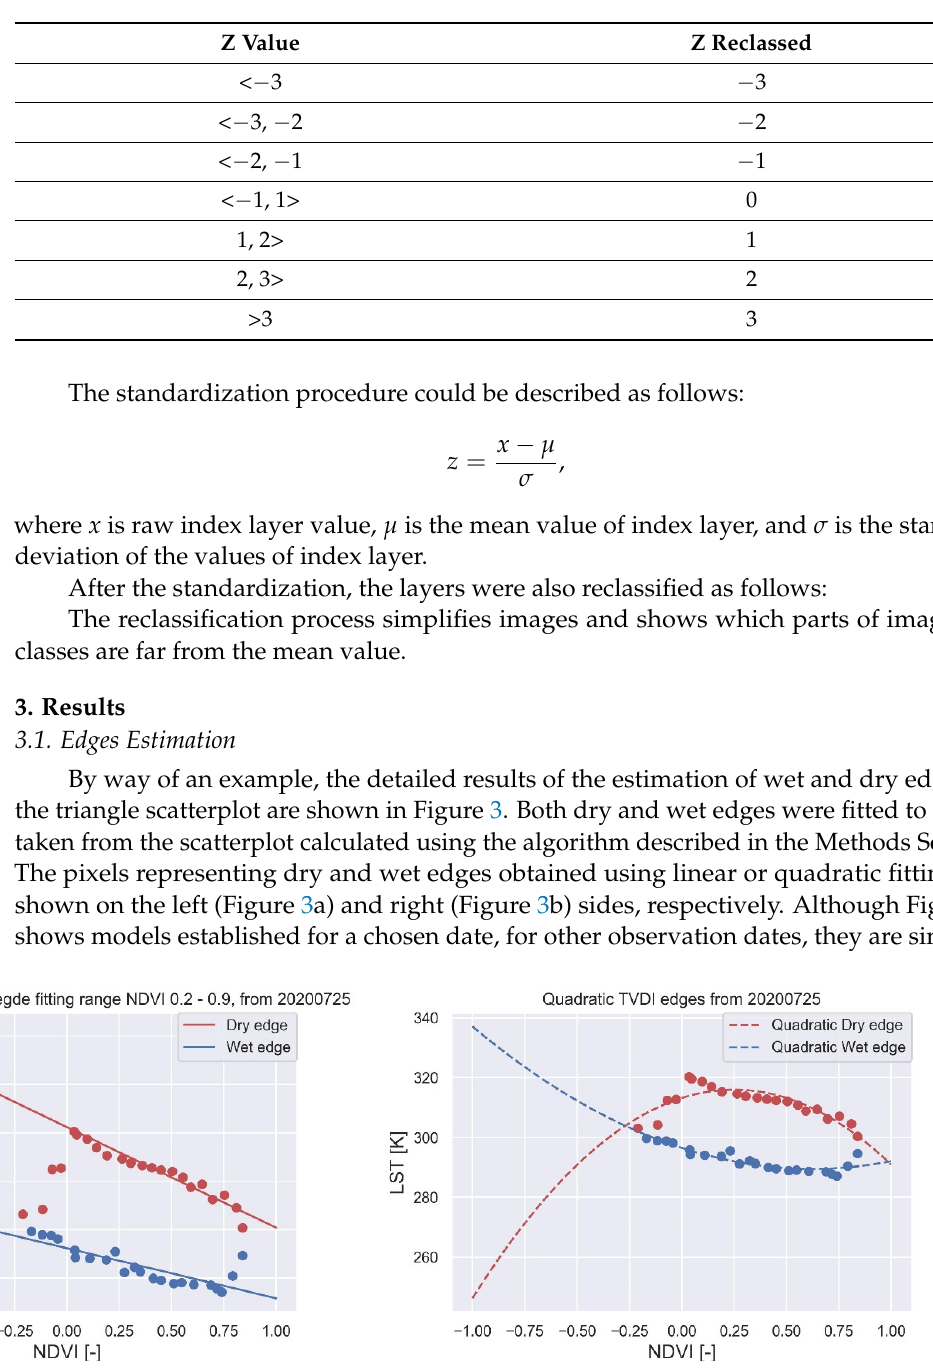
Table 1. Reclassification table.